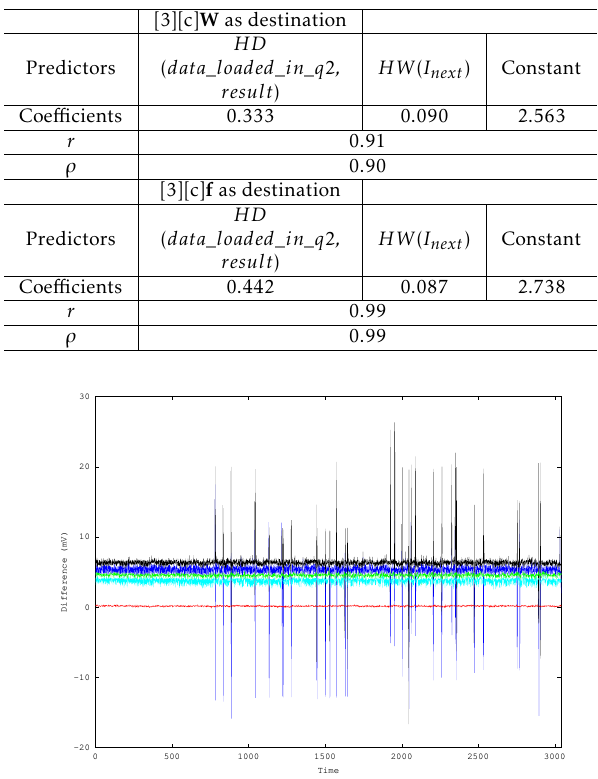
Figure 5. Difference in averaged peak amplitude among chips of the same